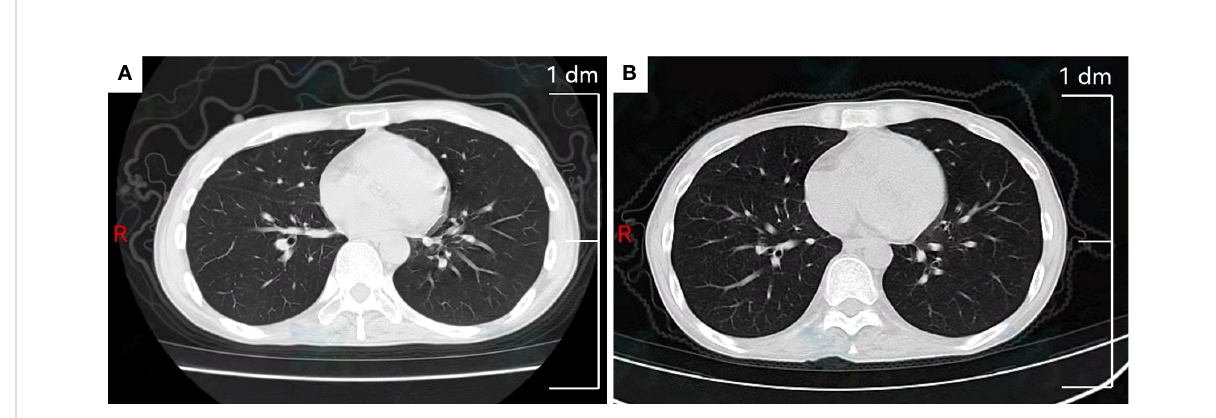
FIGURE 3 Chest computed tomography scan. (A) Slight interstitial changes in the lung before BEP´ chemotherapy. (B) Slight interstitial changes in the lung after BEP´